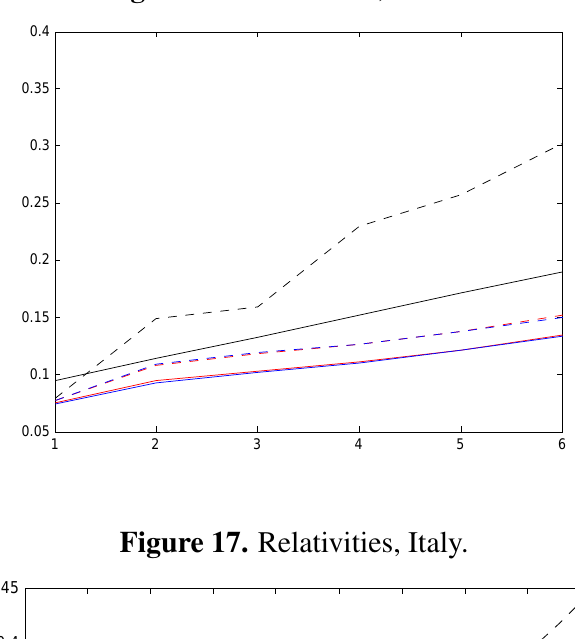
Figure 16. Relativities, Ireland.